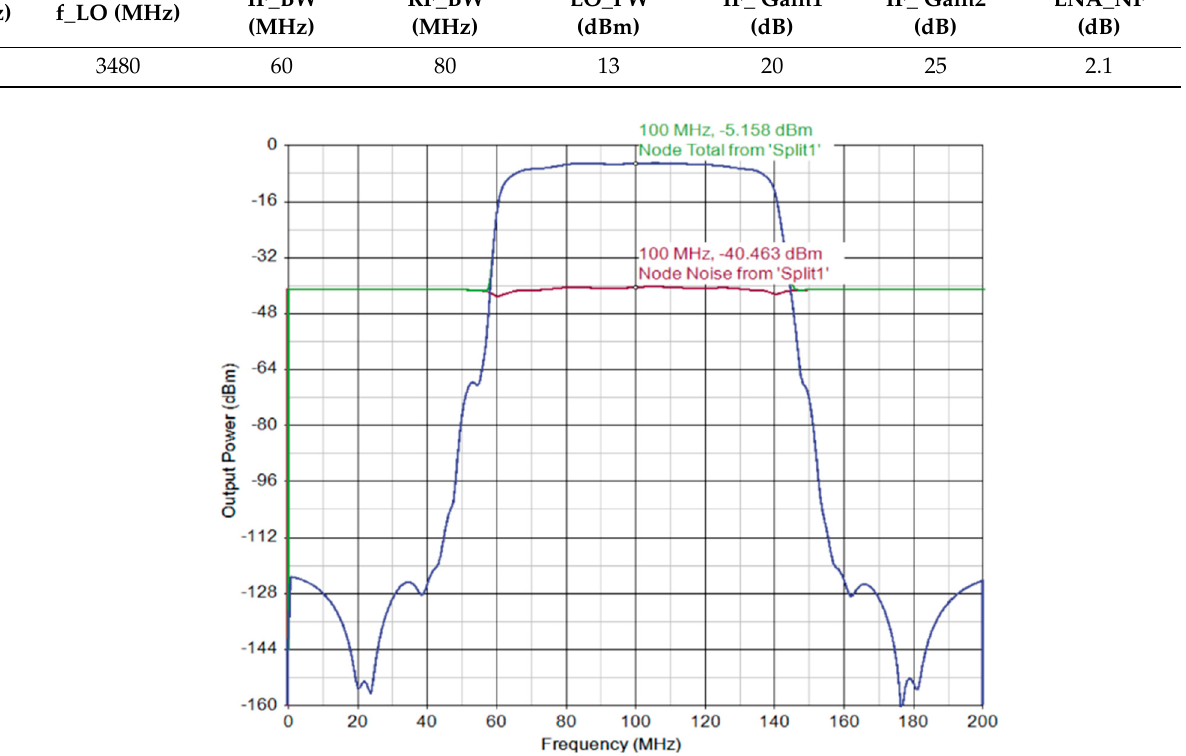
Figure A7. The IF output power of the RF down-converter when sweeping RF signal with an input power level at -50 dBm. power level at − 50 dBm.